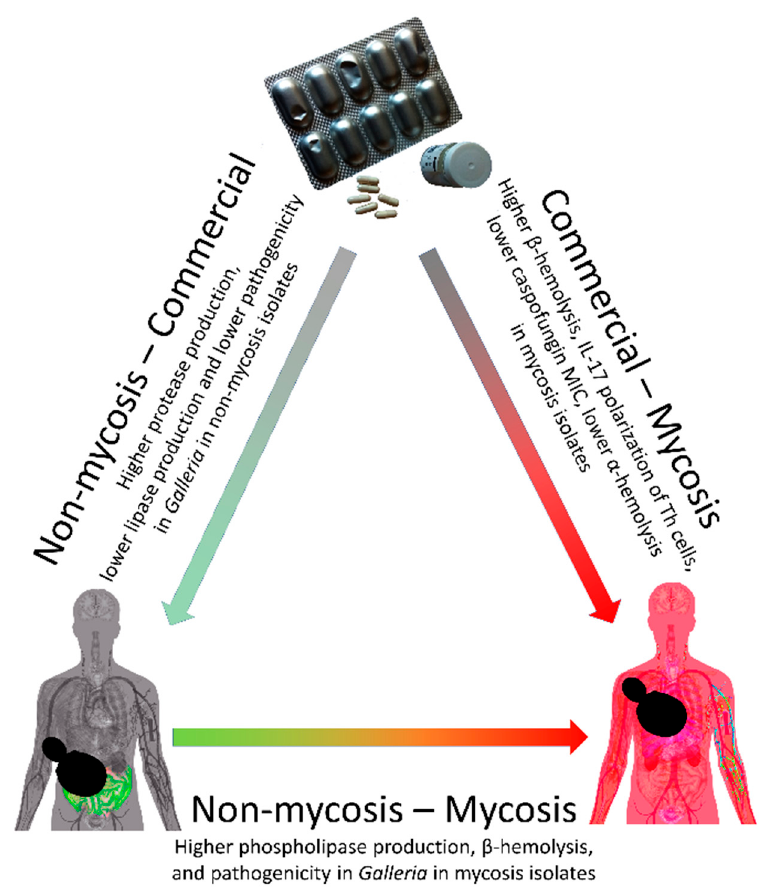
Figure 4. In this study we found variable phenotypic adaptations among Saccharomyces ‘ boulardii’ . Significant differences in product, non-mycosis, and mycosis isolates in phenotypic characteristics, antifungal sensitivity, virulence factors, immune interactions, and pathogenicity in larval model are described for each group-level comparison.